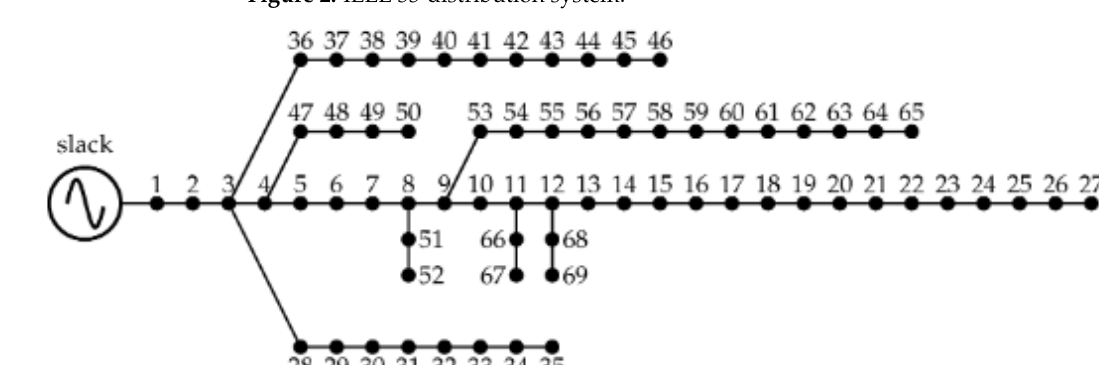
Figure 2. IEEE 33-distribution system.